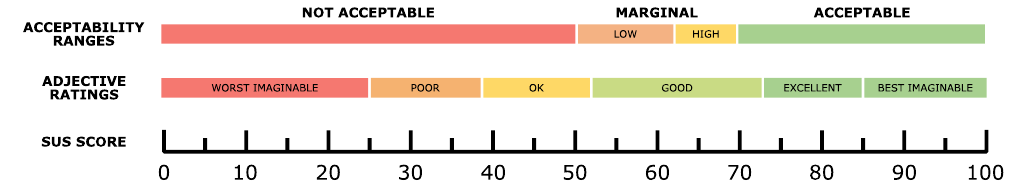
Figure 8. A comparison of mean System Usability Scale (SUS) scores by adjective ratings, and the acceptability of the overall SUS